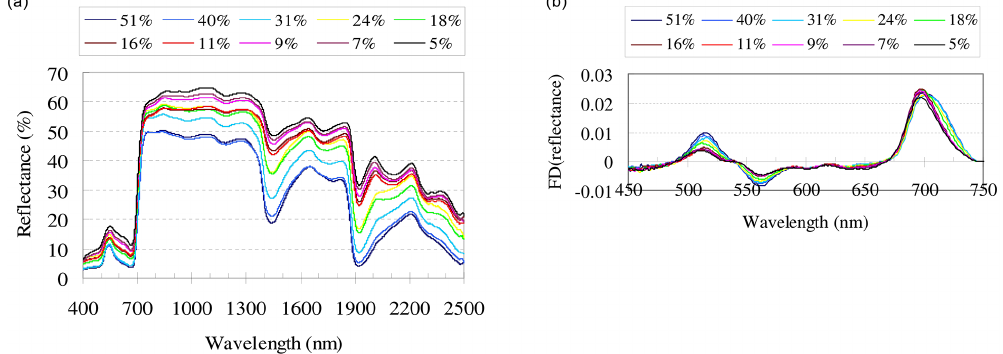
Figure 1. Foliar reflectance spectra of Cinnamomum camphora . (a) Spectral curves showed the reflectance variation of visible–infrared bands due to the changes of water content. (b) An example of the association between the relative water content in fresh and water-stressed leaves and the green peak and red edge spectra features.